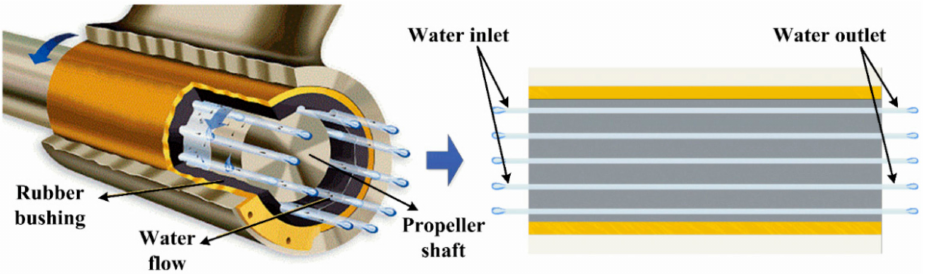
Figure 1. Assembly and operating mechanism for a water-lubricated rubber stern bearing